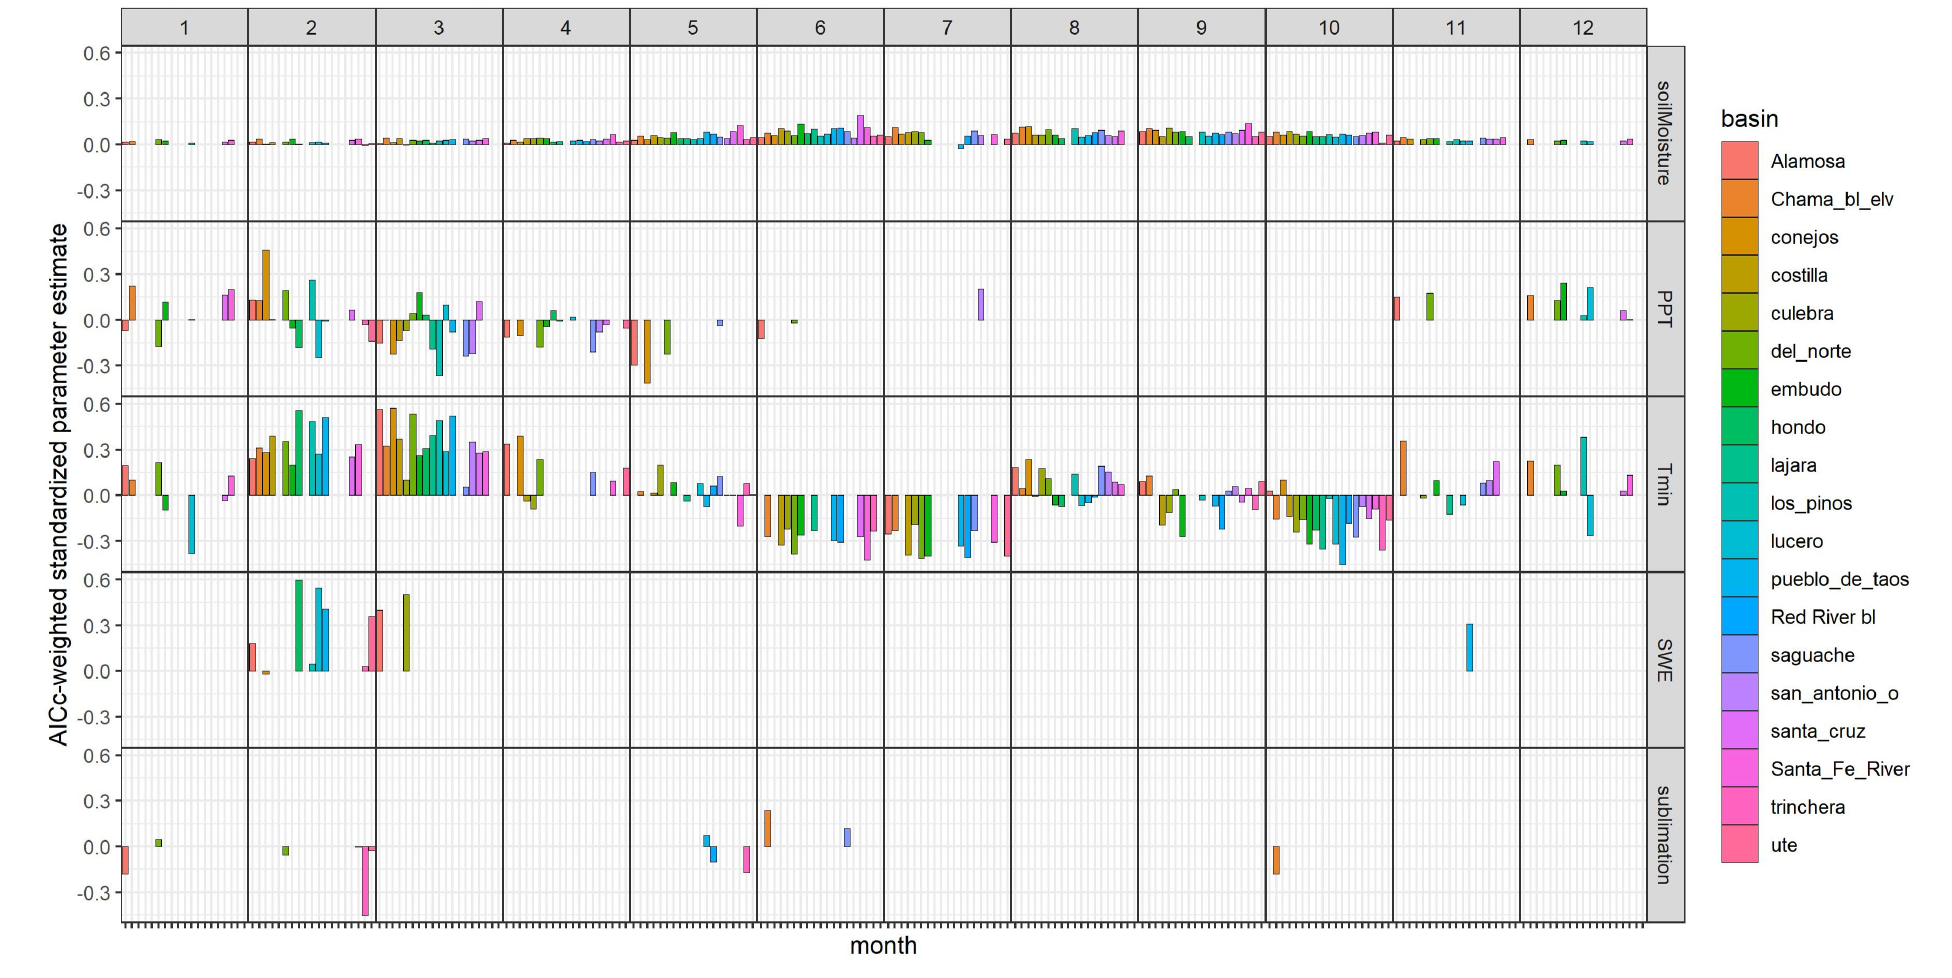
Figure 5. AICc-weighted standardized parameter estimates based on ± 0.4 bivariate correlation cut off, adjusted for intercept-only model. The priority ranking is: 1. Soil Moisture, 2. Precipitation, 3. Minimum Temperature, 4. SWE, and 5.